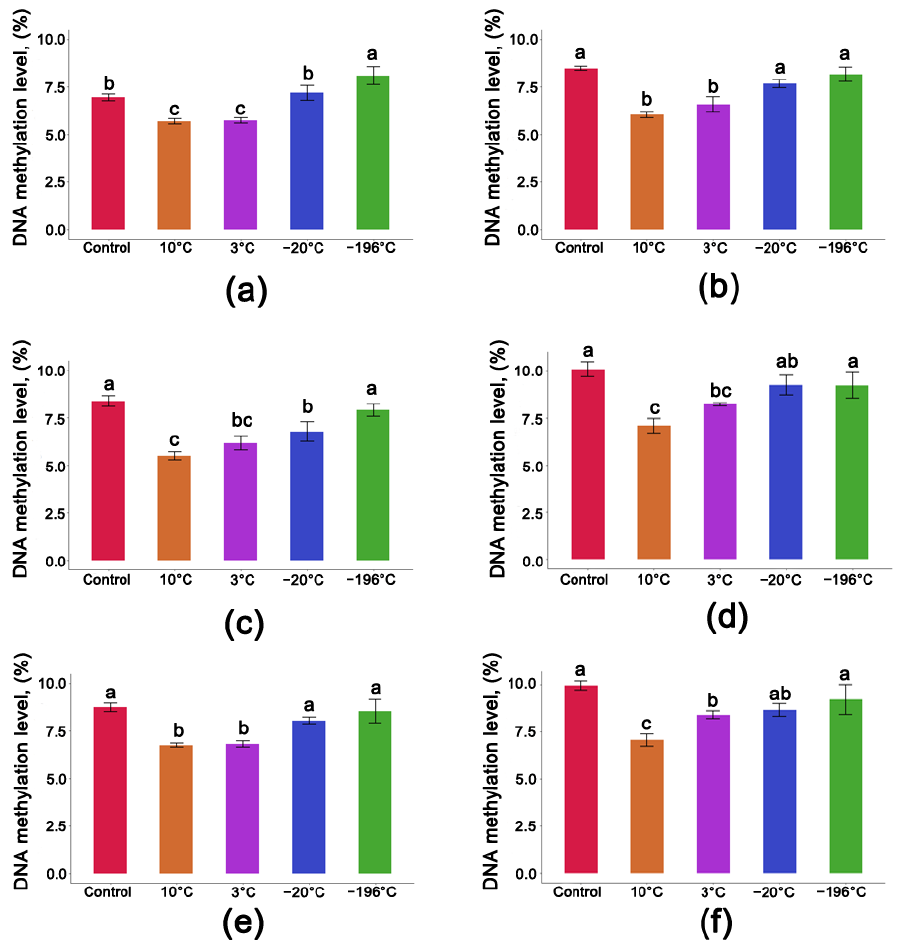
Figure 4. DNA methylation level of P. nigra seeds stored for one year at different MCs: ( a ) Seed Lot 1 stored at MC of 14.5%; ( b ) Seed Lot 1 stored at MC of 7.6%; ( c ) Seed Lot 2 stored at MC of 13.6%; ( d ) Seed Lot 2 stored at MC of 7.8%; ( e ) Seed Lot 3 stored at MC of 12.5%; ( f ) Seed Lot 3 stored at MC of 7.6%. Controls were composed of non-stored seeds. Statistical analysis was conducted using ANOVA and a Duncan test. Values marked with the same letter are not significantly different at p < 0.05. Data represent mean ± SE, n = 4.